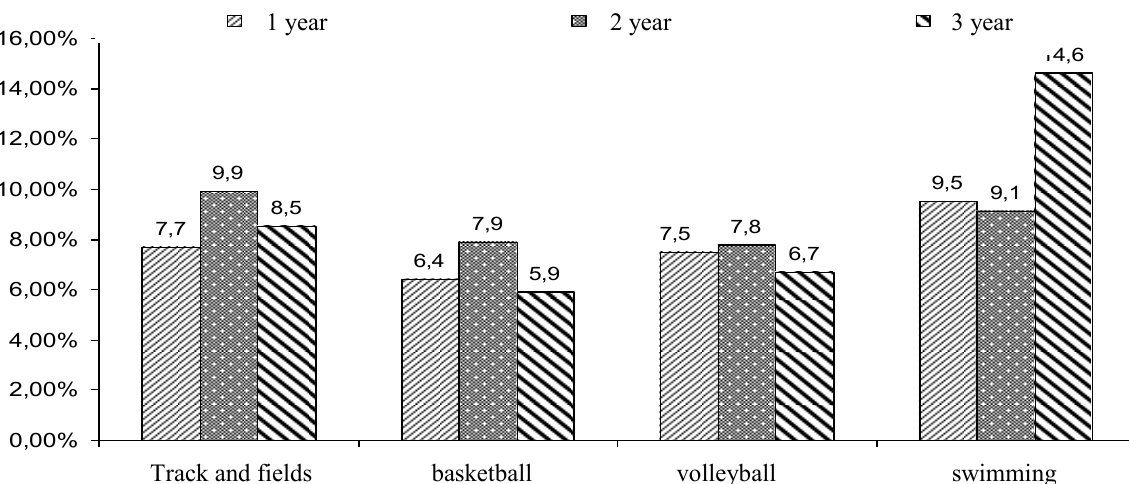
Fig.1. The quantity of classes, missed by NRU” BelGU” in the period of mastering of different curriculum’s sections in discipline “Physical